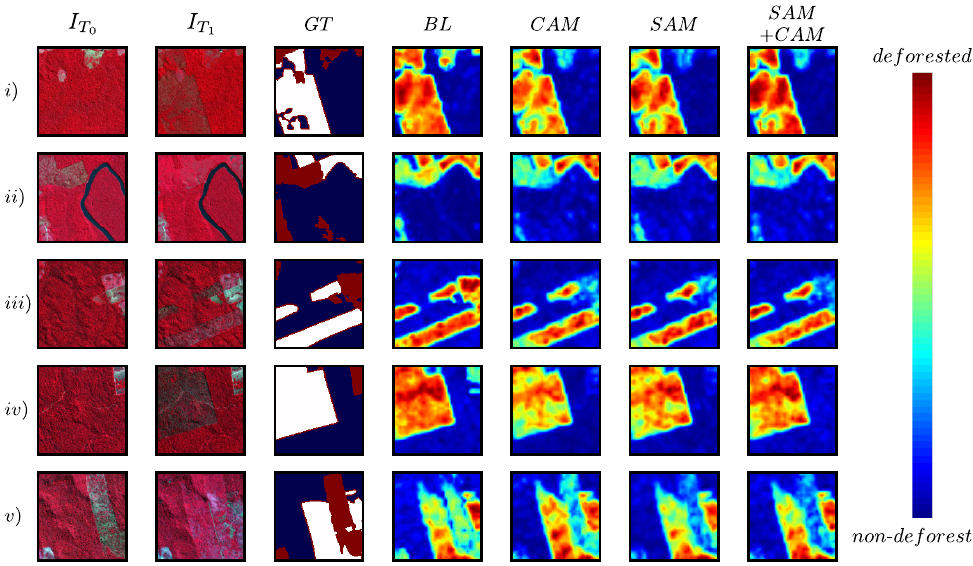
Figure 6. Visual results for the four methods evaluated. Each row presents an example of test patch assessed, and columns, from left to right, are: input image patch taken in 2018; input image patch taken in 2019; ground truth; and the change maps of baseline method; CAM; SAM; and dual-attention method.